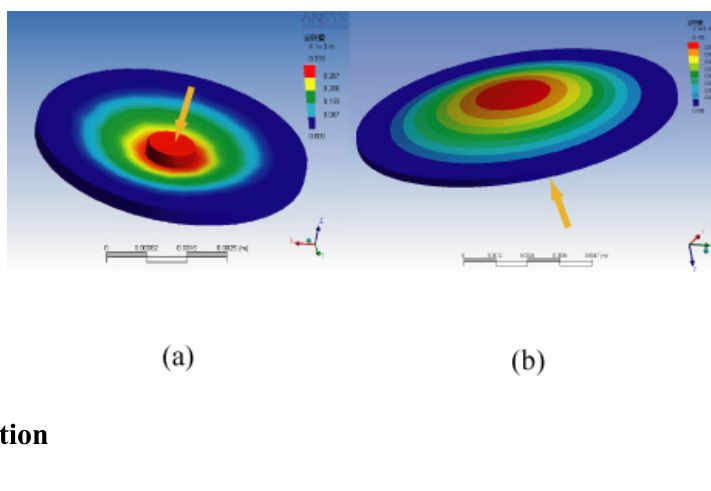
Figure 2. Three dimensional FEM model to validate the deformation of ( a ) the bump layer and ( b ) the layers above the escape